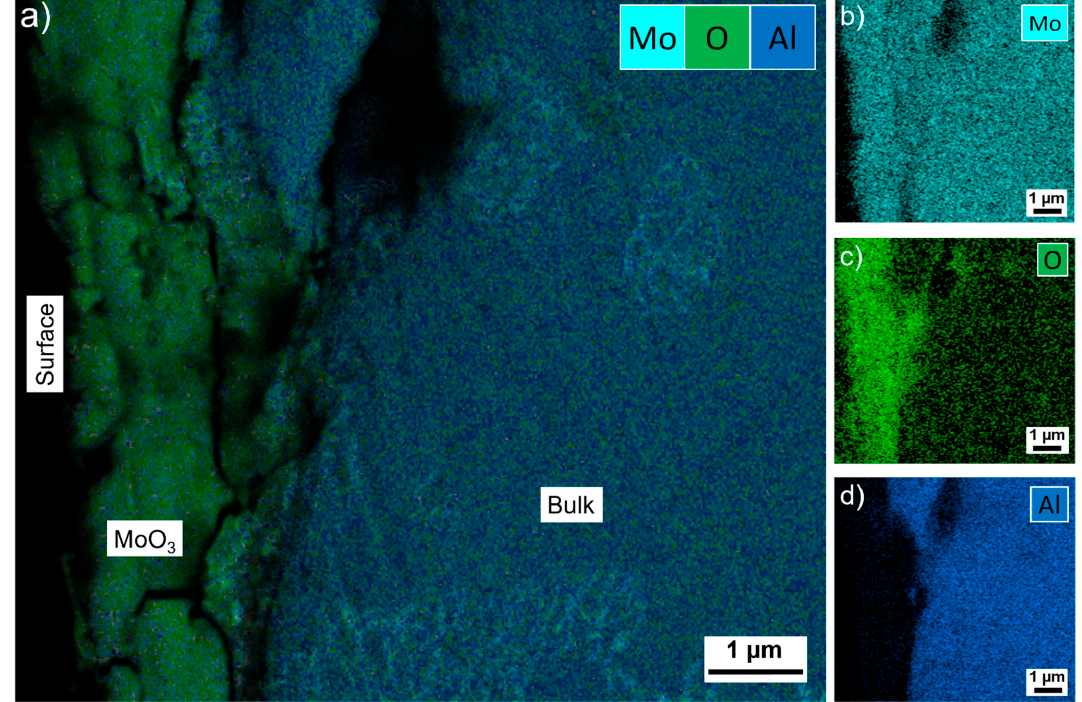
Figure 10. EDS analyses of DS_1h: ( a ) layered compositional map depicting Mo, Al and O content; ( b ) Mo elemental map; ( c ) O elemental map and; ( d ) Al elemental map. In the case of DS_3h, the SEM images (Figure 8c,d) display a more homogeneous